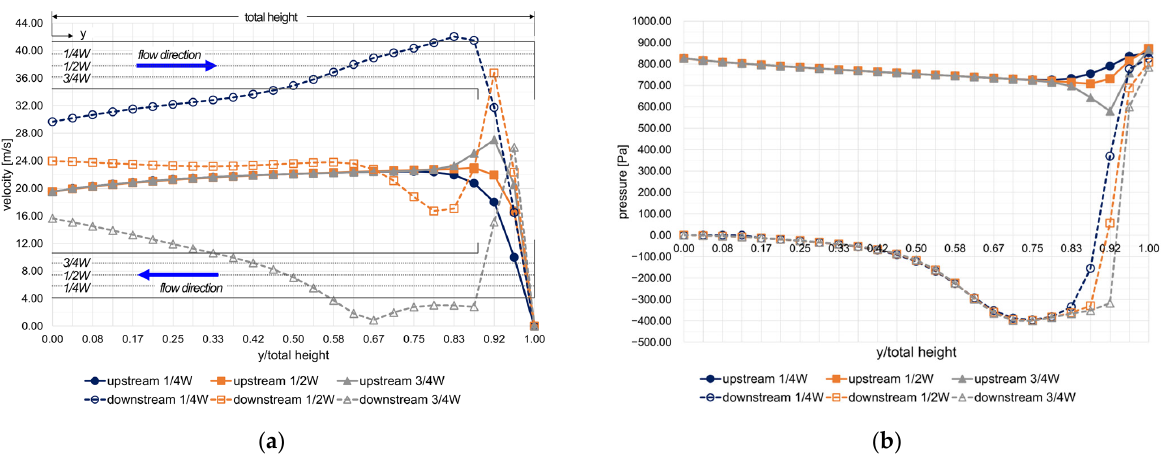
Figure 9. Flow characteristics of the upstream and downstream channels (Re = 24,230): ( a ) velocity distribution; ( b ) pressure distribution.